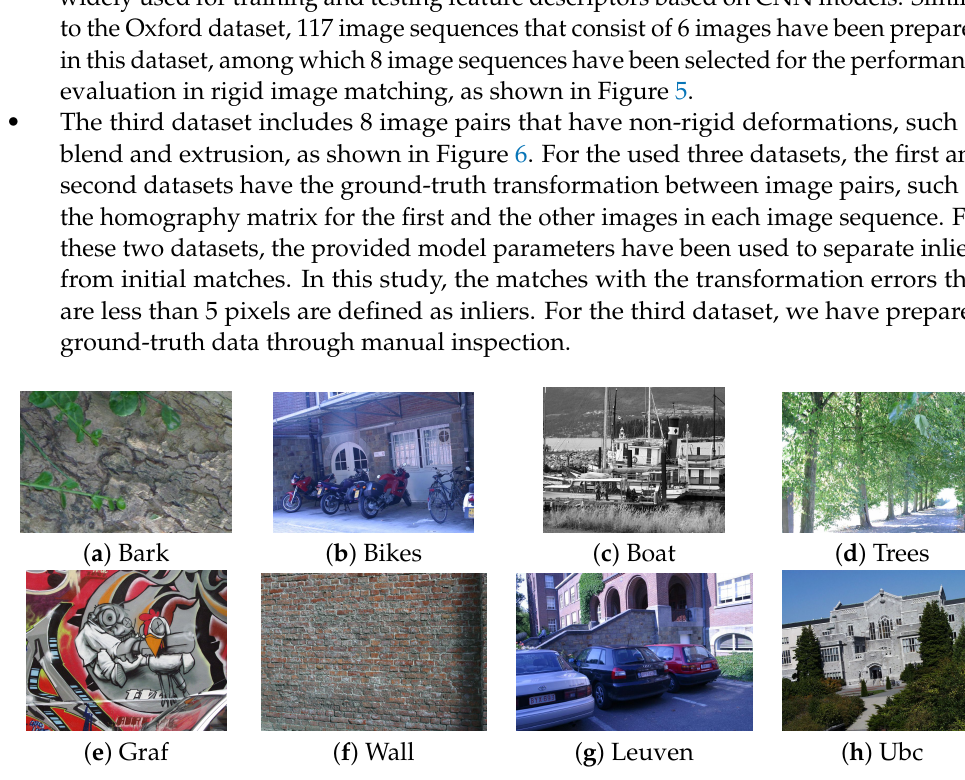
Figure 4. The Oxford dataset (close-range dataset 1).